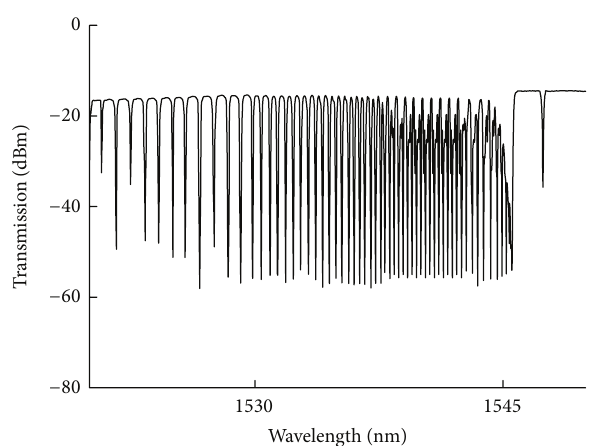
Figure 2: Original transmission spectrum of the TFBG.